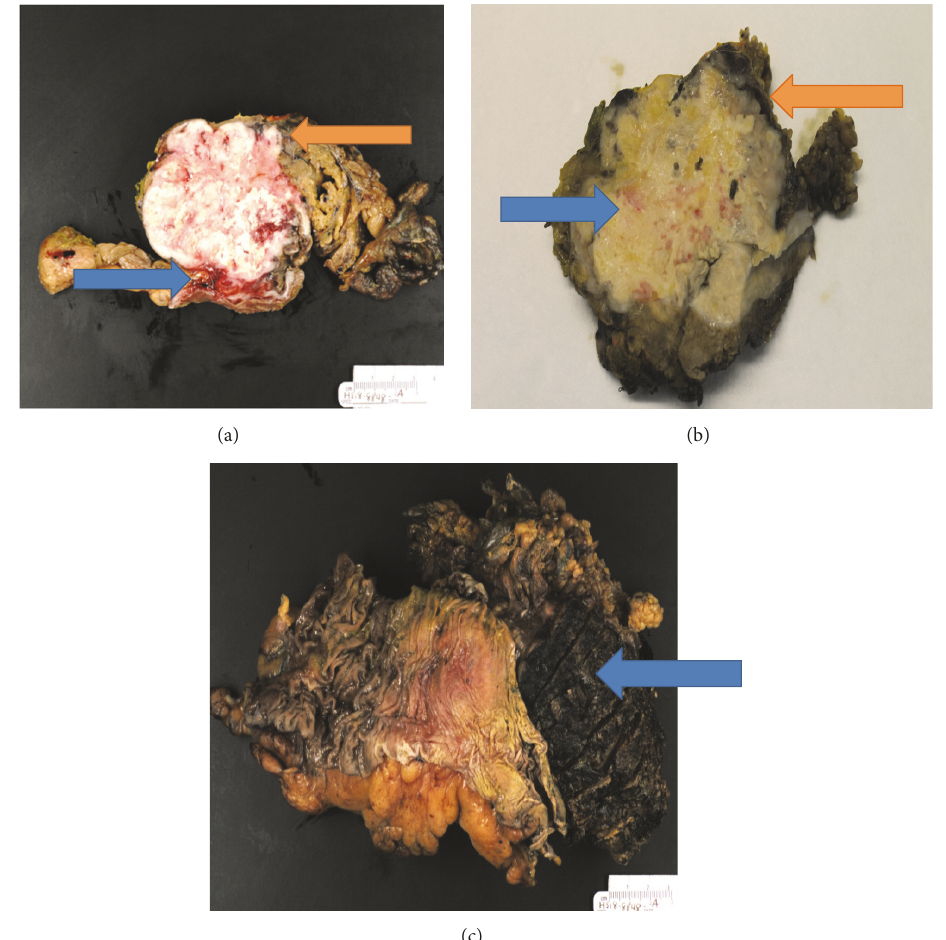
Figure 2: Gross findings: (a) Tan-white necrotic mass abutting the abdominal wall (blue arrow) and infiltrating the omental fat (orange arrow); (b) mass with extensive necrosis abutting the liver (blue arrow) and anterior abdominal wall (orange arrow); (c) tumor abutting the adventitial surface of the ascending colon (blue